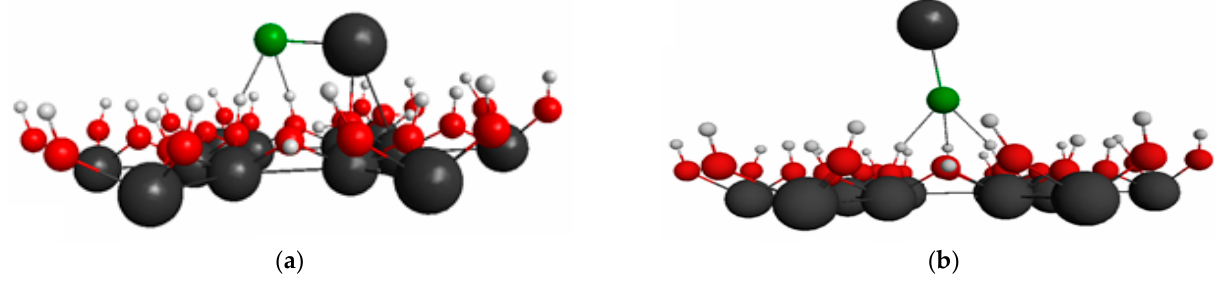
Figure 12. Optimum positions of the NaCl molecule near the kaolinite–hydroxyl surface: ( a ) molecular axis is parallel to the surface; ( b ) molecular axis is perpendicular to the surface.